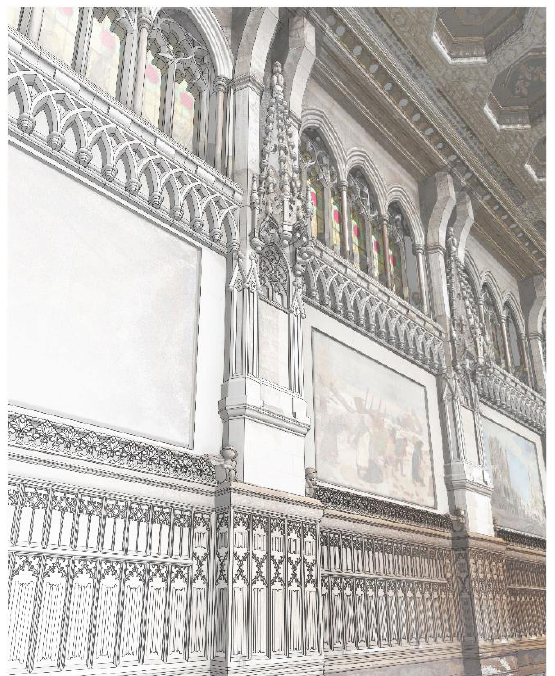
Figure 4: High level of detail BIM overlaid with photogrammetric textured model of the Senate Chamber West Elevation (CIMS, 2017).